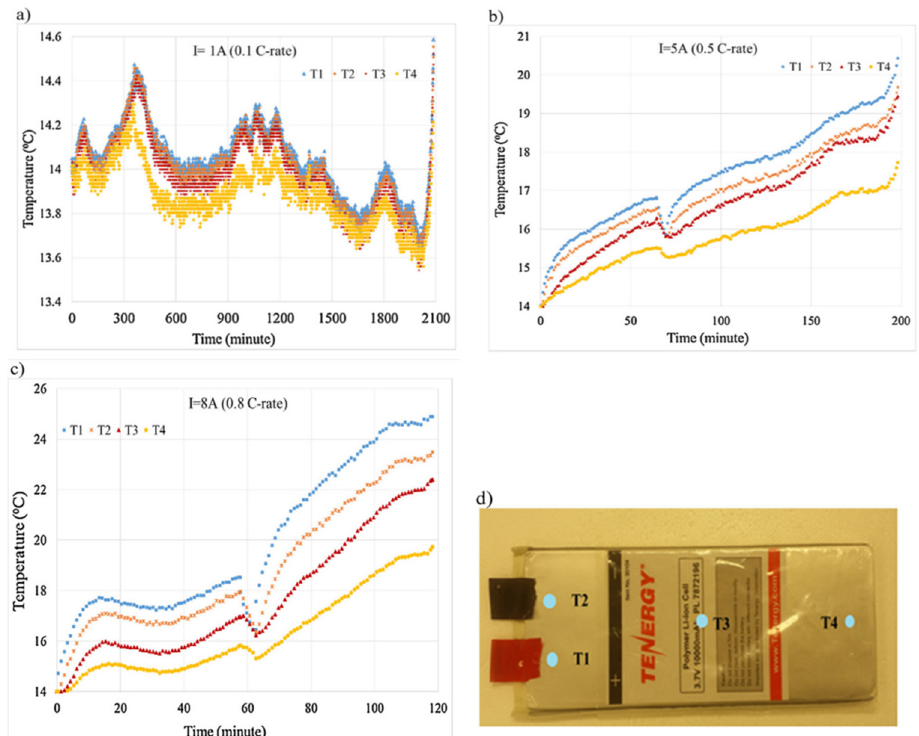
Figure 2. Surface temperature profiles at ( a ) 0.1 C-rate, ( b ) 0.5 C-rate and ( c ) 0.8 C-rate. ( d ) Temperature is measured close to the positive tab (T1, blue lines), close to the negative tab (T2, orange lines), center (T3, red lines) and at the bottom of the battery (T4, yellow lines) [7].